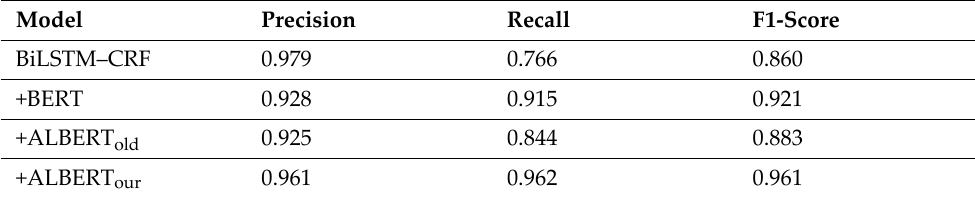
Table 12. Experimental performance of variant models on the TPCNER dataset.